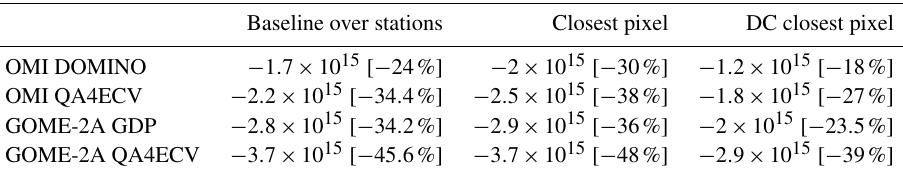
Table 6. Daily median biases for all the stations together for the baseline (pixels above the stations) and when relaxing the comparison criteria for the original and dilution-corrected comparison (in moleccm − 2 ). Values are reported after filtering out GBi values smaller than 2 × 10 15 moleccm 3